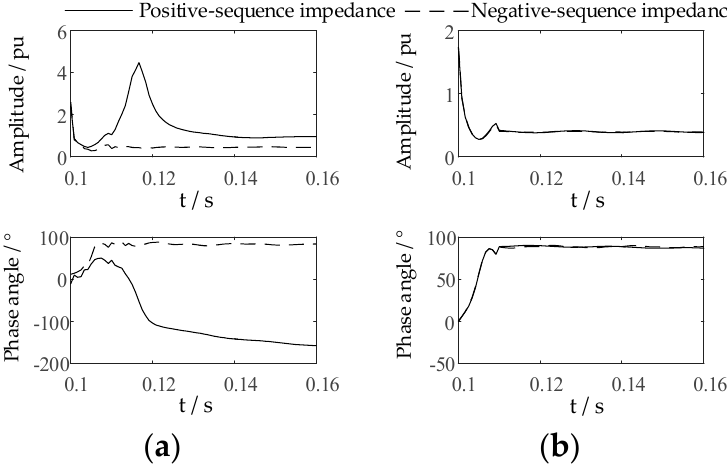
Figure 11. Difference features of the positive ‐ and negative sequence ‐ impedance : ( a ) DFIG; and ( b ) Figure 11. Di ff erence features of the positive- and negative sequence-impedance: ( a ) DFIG; and ( b ) SG. SG. Therefore, the fault direction can be di ff erentiated by using the di ff erence index between the positive- and negative-sequence measured impedance which can be expressed